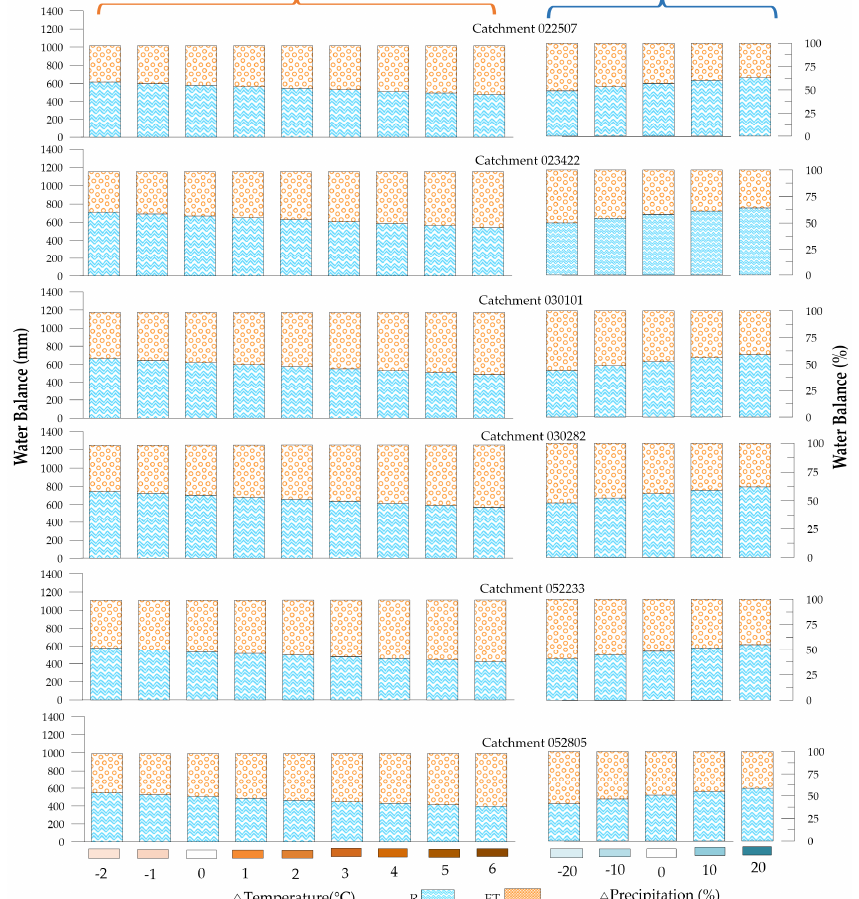
Figure 6. Water balance. Each bar represents the total multiannual precipitation for each watershed. The orange fraction of each bar represents evapotranspiration (ET) and the blue fraction represents runoff. The figure is divided into two parts, the first corresponding to constant precipitation (current conditions) and changes in temperature (presented in the left part of the figure, those included in the orange key) and the second corresponding to a constant temperature (current conditions) and changes in precipitation (presented in the right part of the figure, those included in the blue key). On the left, the figure shows the water balance in mm to represent the total precipitation values of each basin; on the right, the water balance is presented in percentages so that they are graphically comparable with the results of the balances associated with the change in temperature.